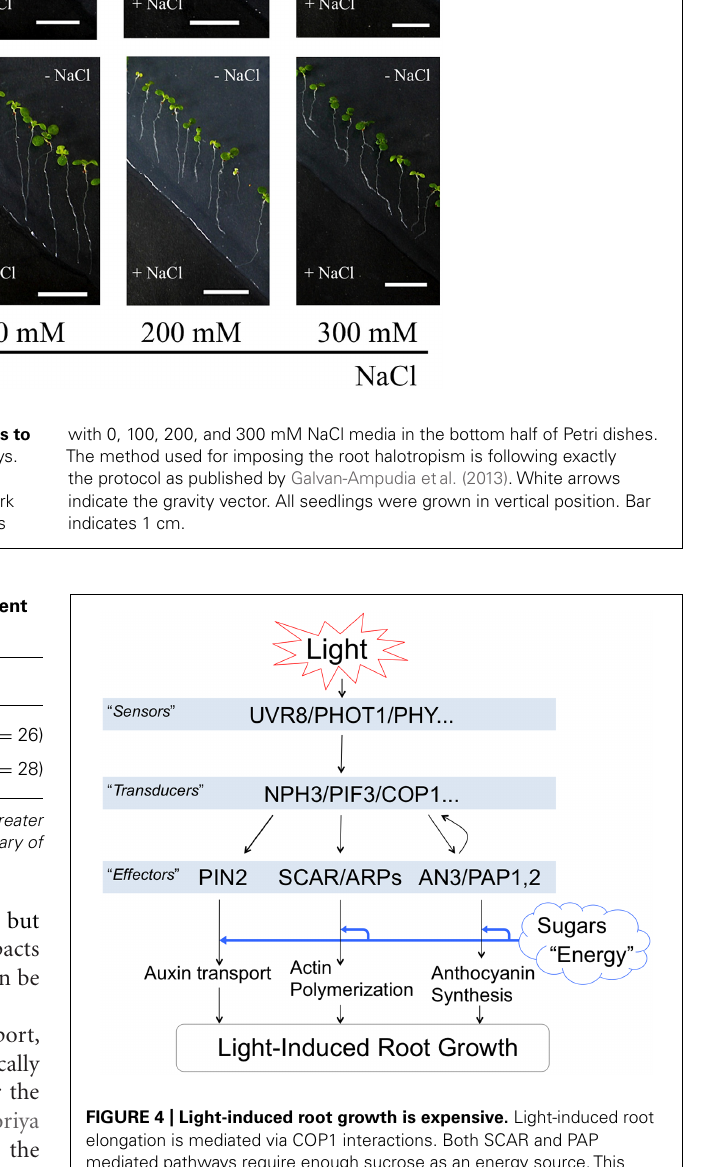
FIGURE 4 | Light-induced root growth is expensive. Light-induced root elongation is mediated via COP1 interactions. Both SCAR and PAP mediated pathways require enough sucrose as an energy source.This figure is based on following references: Dyachok etal. (2011),Wan